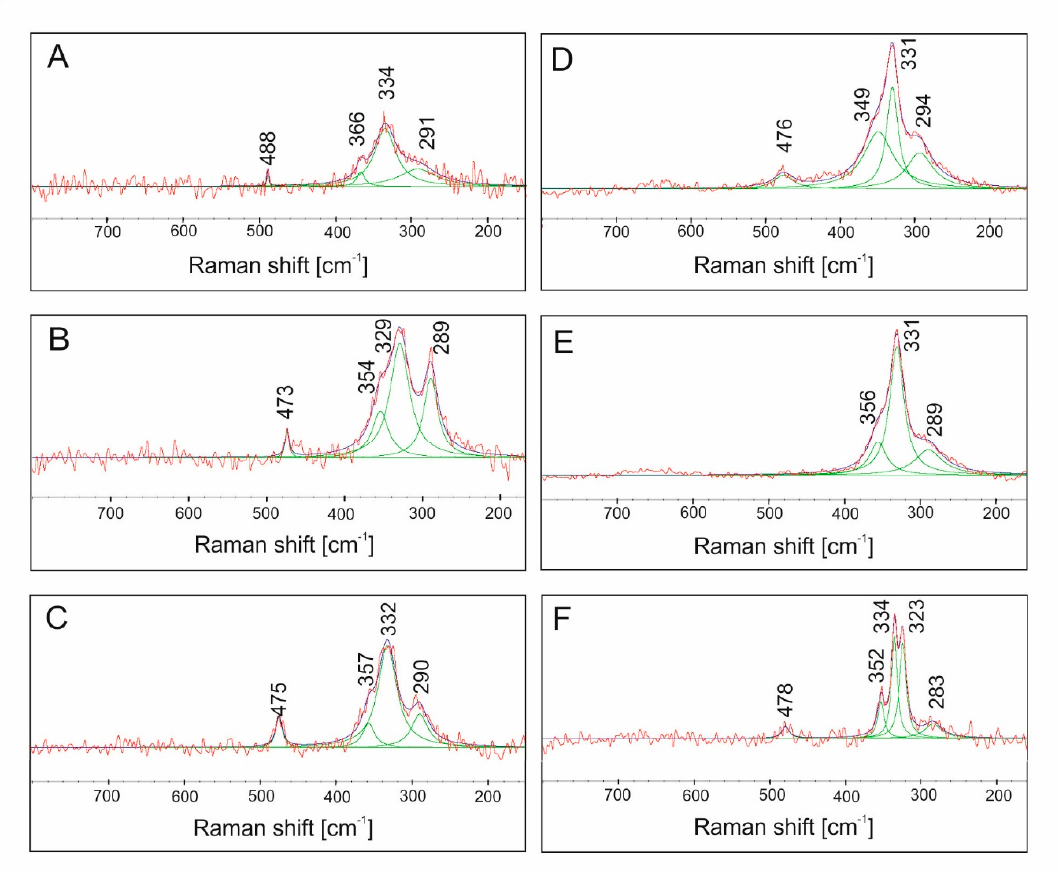
Figure 15. Raman spectra of: ( A ) Cu 2 FeSnS 4 , ( B ) Cu 2 (Mn 0.2 Fe 0.8 )SnS 4 , ( C ) Cu 2 (Mn 0.4 Fe 0.6 )SnS 4 , ( D ) Cu 2 (Mn 0.6 Fe 0.4 )SnS 4 , ( E ) Cu 2 (Mn 0.8 Fe 0.2 )SnS 4 , ( F ) Cu 2 MnSnS 4 . There is a variation in the frequency of the characteristic band of stannite: a main vibration mode at ~330 cm − 1 .